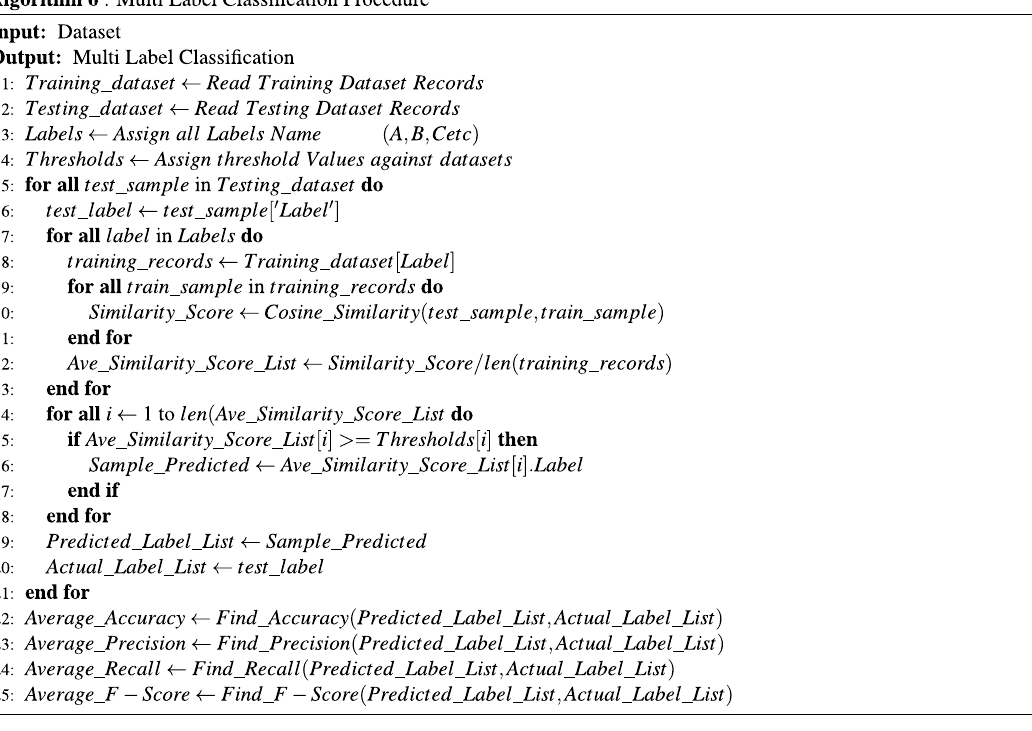
Figure 7. Multi label classification